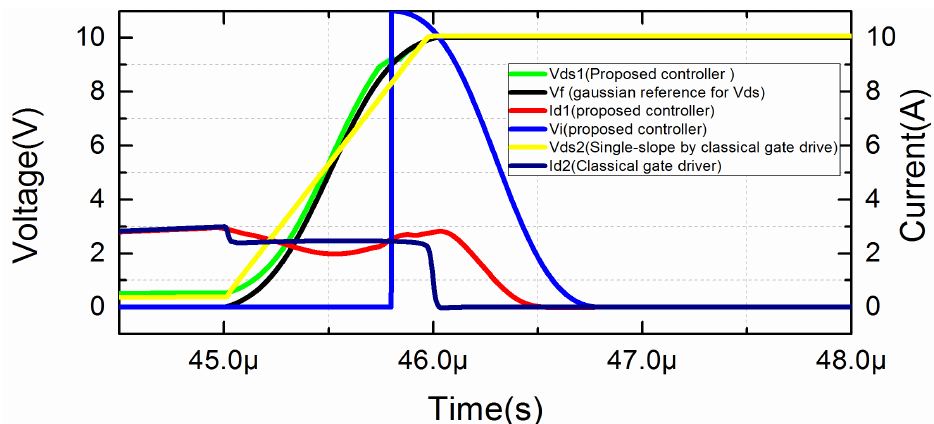
Figure 10. Pspice simulation for SiC MOSFET during turn-off with 1 µs rising edge time of V f (reference voltage) and 1 µs falling edge time of V i (the voltage to control current).